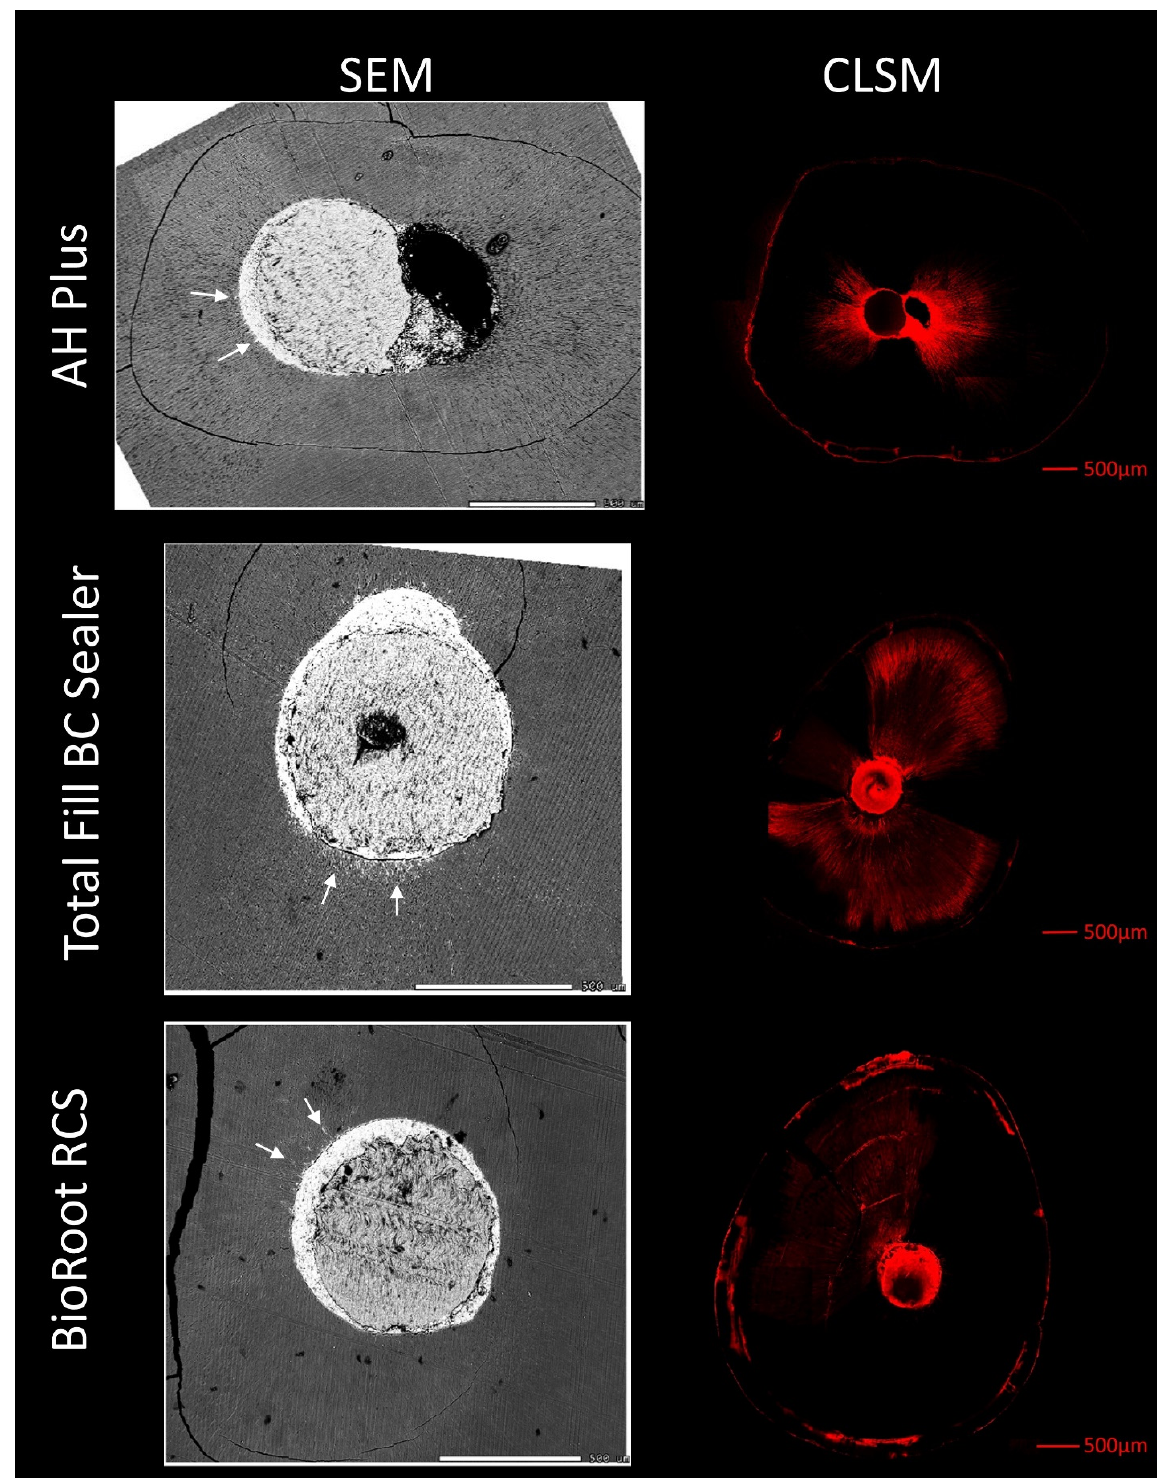
Figure 3. Corresponding scanning electron microscope (SEM) and confocal laser scanning microscope (CLSM) images of root slices filed with gutta-percha and AH Plus, Total Fill BC Sealer, and BioRoot RCS, as indicated. White arrows indicate the sealer penetration depth found in SEM images. Rhodamine B dye reached the root surface of all specimens in the CLSM images. No correlation between sealer penetration in SEM and rhodamine B penetration in CLSM could be detected. In SEM images, sealer presents as white, and can be detected via EDX analysis. Gutta-percha, which can also be detected via EDX analysis, presents as gray. Sealer penetration occurred only in areas with a high number of dentinal tubules.